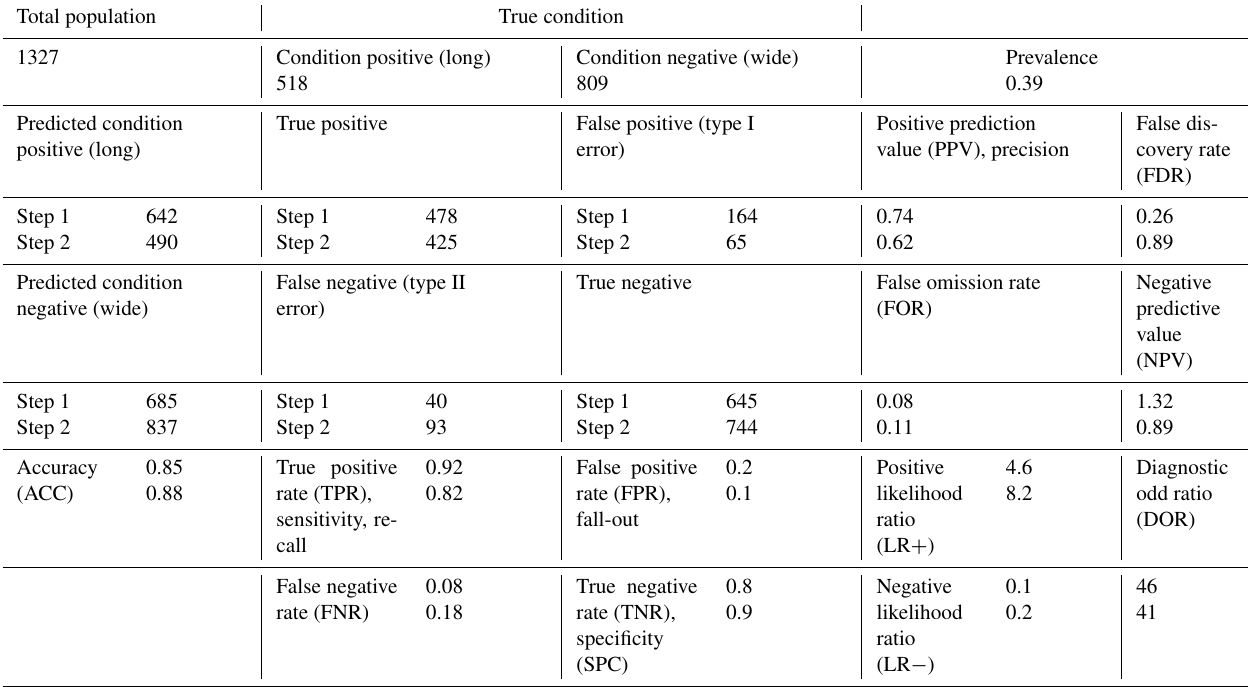
Table 1. The confusion matrix for the classification performed in the two steps of the algorithm and the associated statistics. Total population True